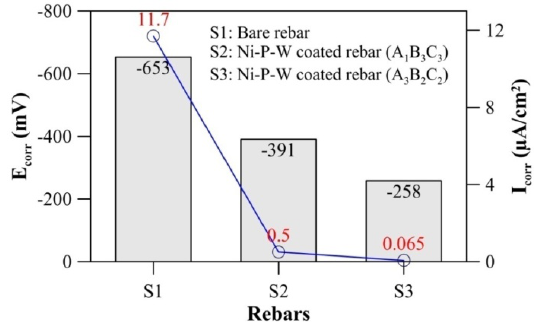
Figure 6. Potentiodynamic polarization parameters of bare and electroless Ni-P-W coated rebar